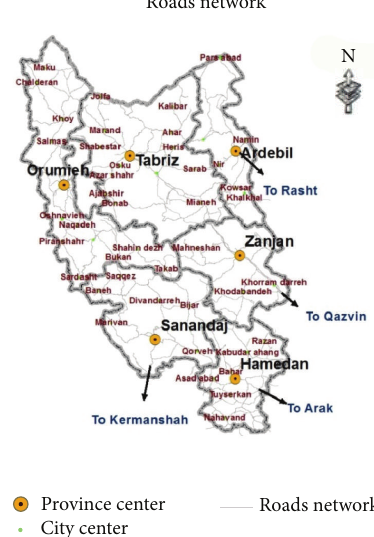
∗ ( Cost, risk) priority set is ordered by left to right. ∗∗ Frequency is regarding 365 iterations.